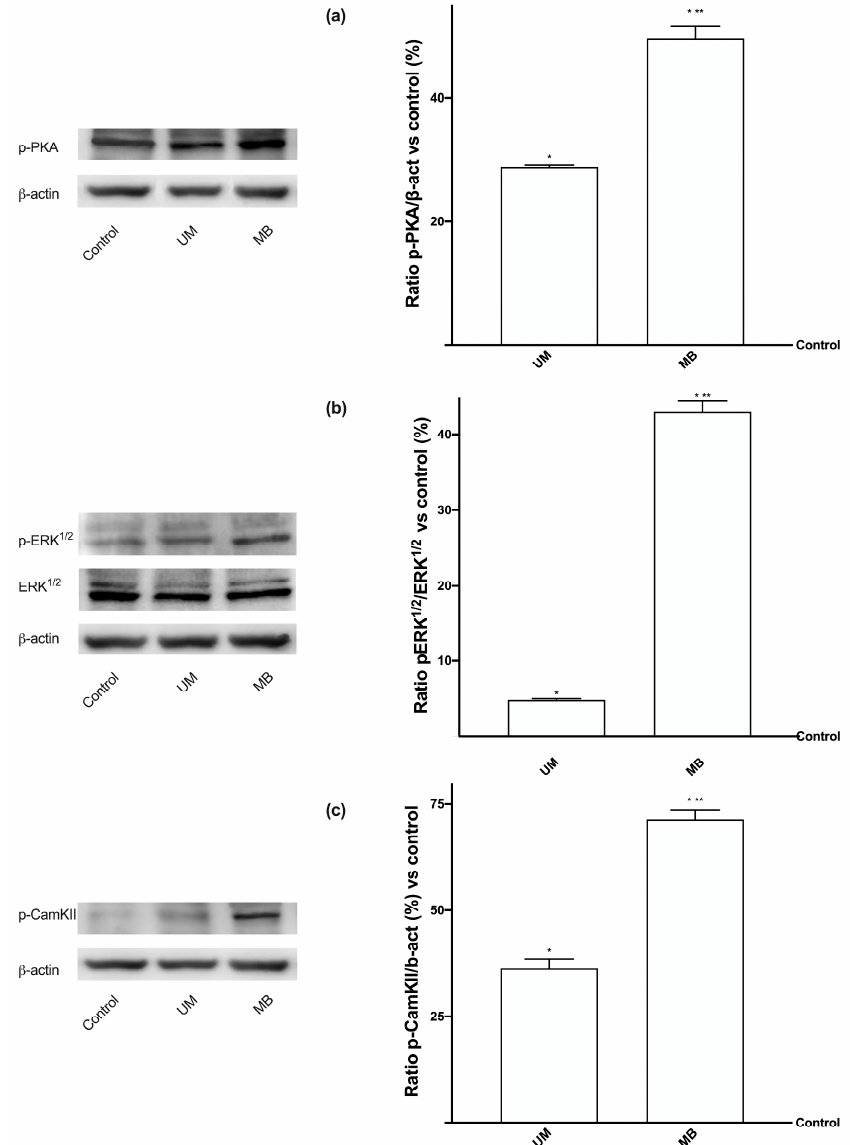
Figure 4. Western blot and densitometric analysis of PKA, ERK / MAPK, and CamKII on Caco-2 cells. Western blot and densitometric analysis of PKA ( a ), ERK / MAPK ( b ), and CamKII ( c ), analyzed on whole Caco-2 lysates at 3 h of stimulations. The images reported are an example of each protein from five independent experiments reproduced in triplicate. Data are expressed as means ± SD (%) of five independent experiments normalized on specific total protein when possible and verified on β -actin detection. The abbreviations are the same as reported in Figure 1. * p < 0.05 vs. control; ** p < 0.05 vs. UM.